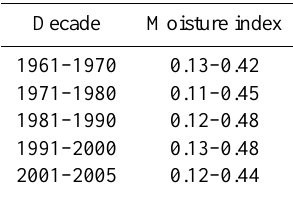
Table B1. The minimum and maximum moisture indexes given by Liu and Gao (2008) in different decades from 1961 to